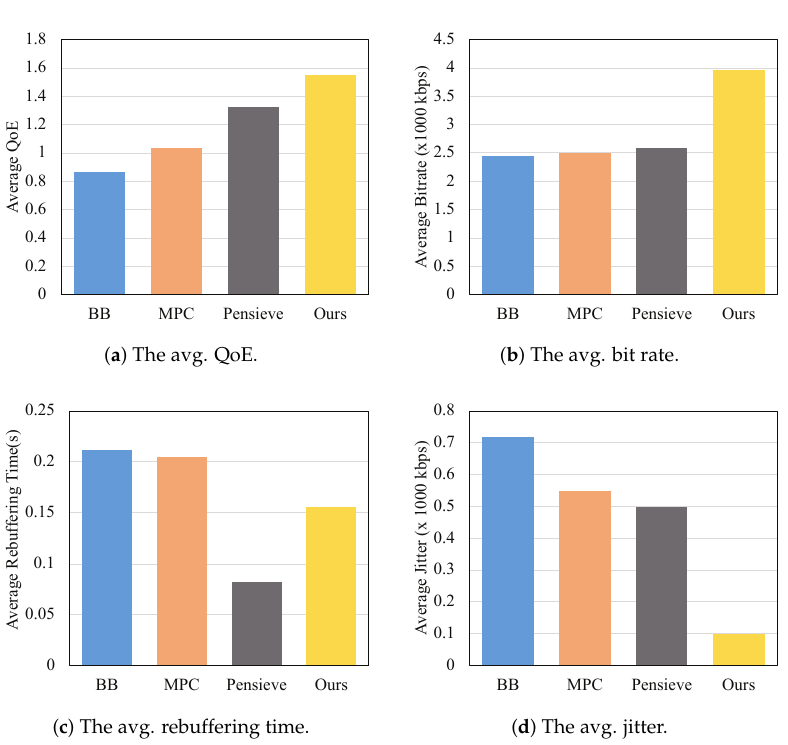
Figure 4. The comparison results between our proposed SR-telemedicine and baseline algorithms. ( a ) The average QoE. SR-Telemedicine can improve the average QoE by 17 (cid:118) 79%. ( b ) The average bit rate. SR-Telemedicine can largely increase the average video bit rate due to VSR processing on the edge node. ( c ) The average rebuffering time. SR-Telemedicine is worse than Pensieve because the reconstruction of the low-resolution video chunks at the edge node would increase the amount of transmitted data and thus increase the probability of rebuffering. ( d ) The average jitter. SR- Telemedicine can always promote the low resolution to a higher resolution, and thus video quality switching can be effectively